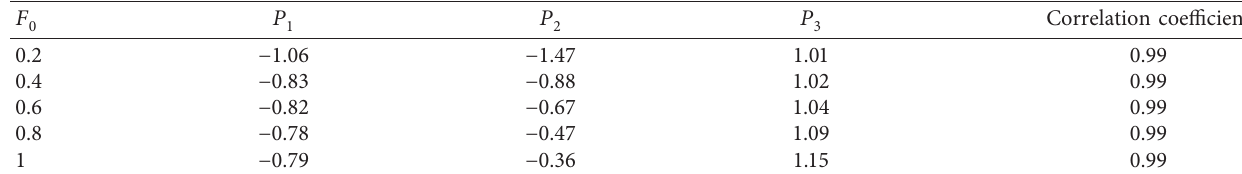
Figure 9: T − R curve and T − F curve under the working conditions of Scheme 4. (a) T − R curve. (b) T − F 0 Table 7: Relationship between dimensionless temperature and dimensionless